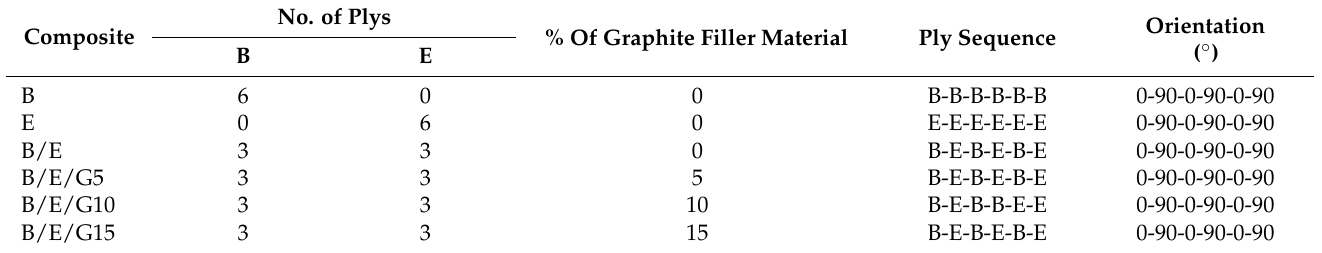
Table 2. Ply sequence and orientation of basalt and E-glass hybrid